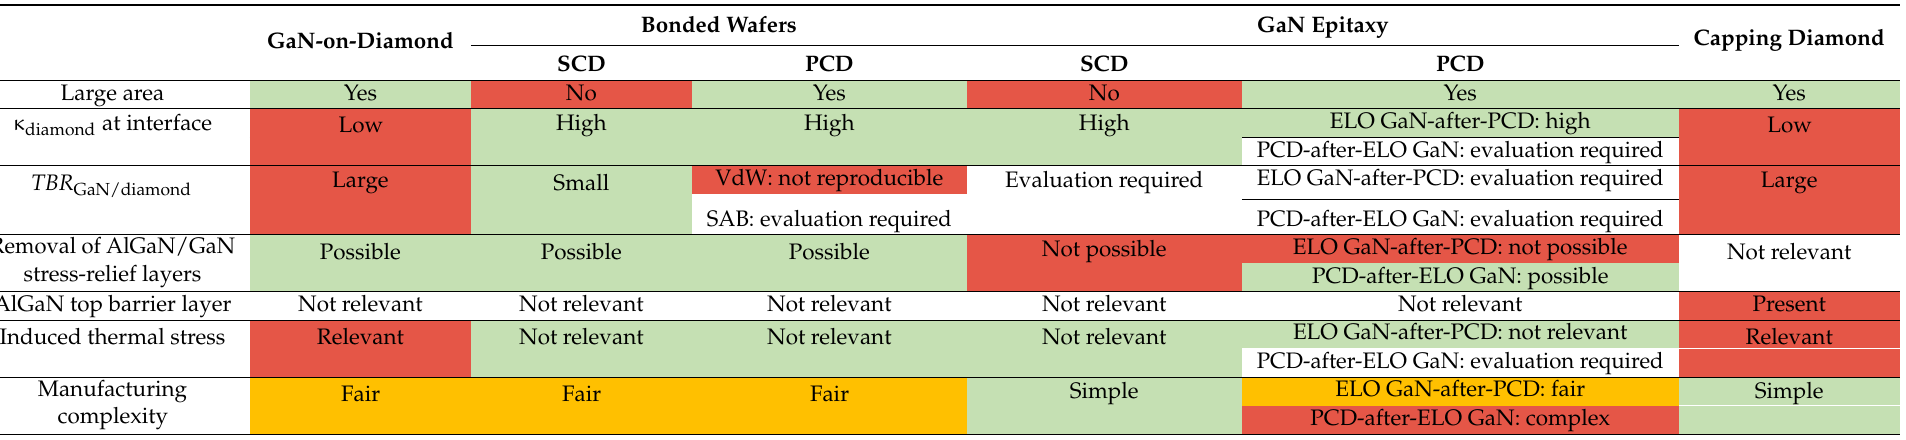
Table 7. Current advantages and disadvantages of each